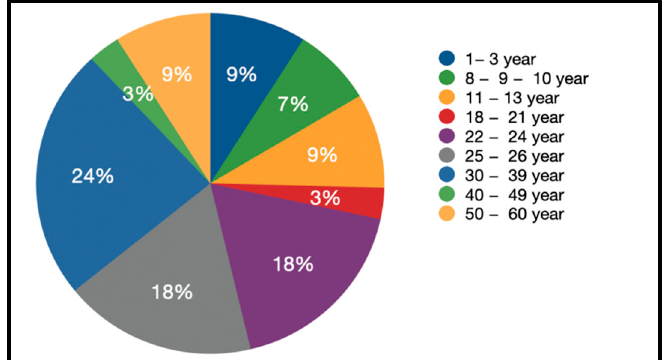
Figure 5. Age of experience participants.